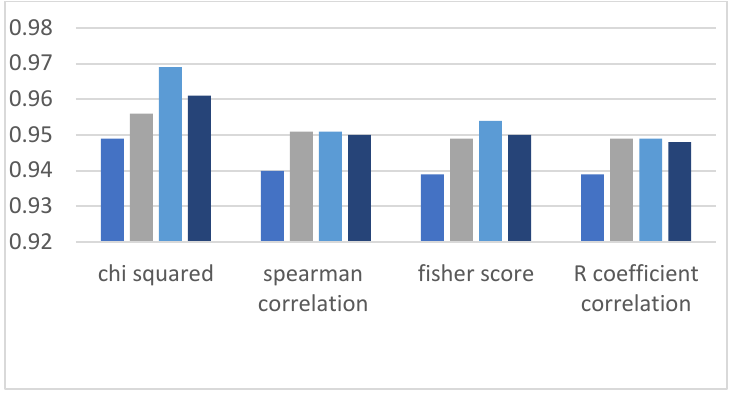
Figure 17. Recall using enhanced DF.